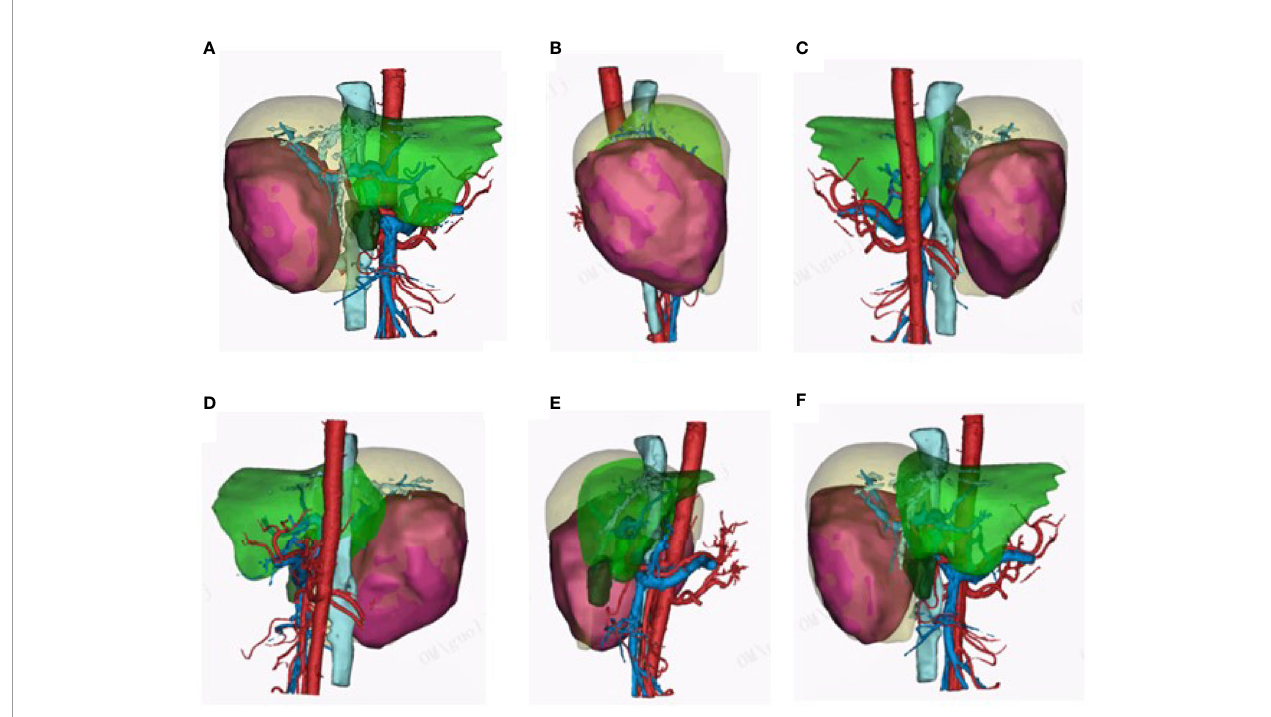
FIGURE 2 | 3D visualization pictures. (A – F) 3D visualization clearly reconstructed the hepatic vein, hepatic artery, portal vein, and tumor feeding artery. The 3D visualization pictures from different angles are